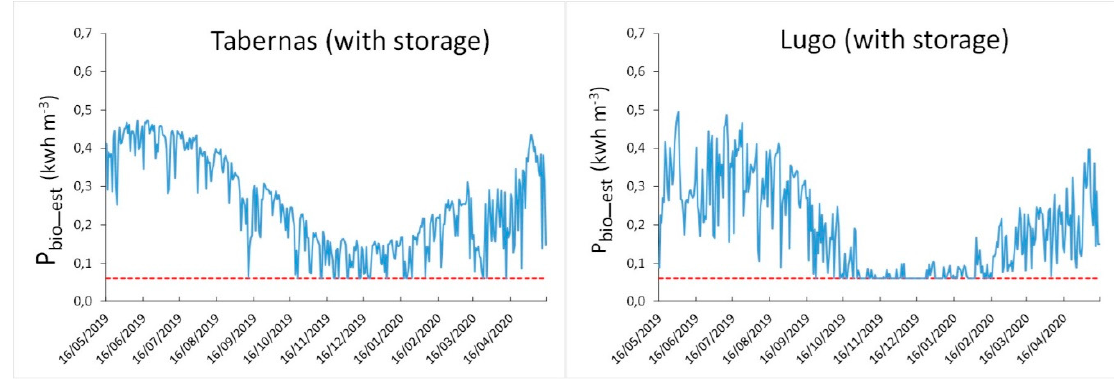
Figure 4. Temporal evolution of power from biomass using storage along with energy consumption (0.06 kWh m − 3 ).